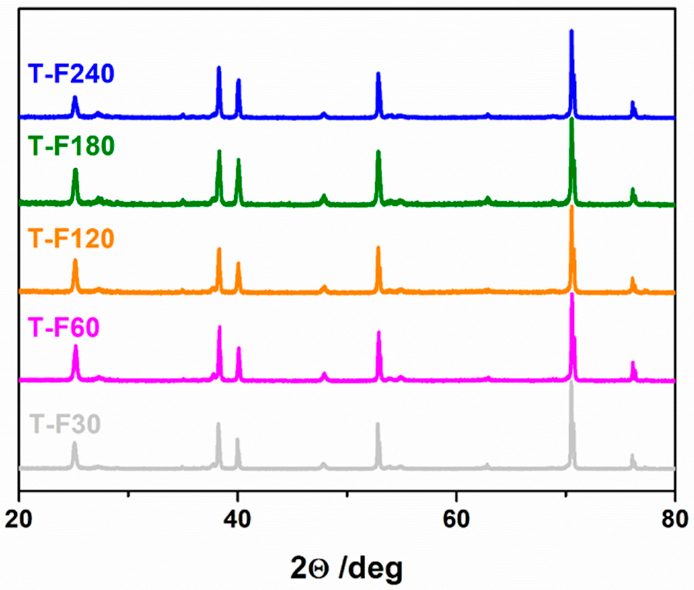
Figure 7. XRD patterns for calcined TiO 2 nanotubes treated with different laser fluences. Reprinted with permission from [45]. Copyright (2022) Creative Commons Attribution.